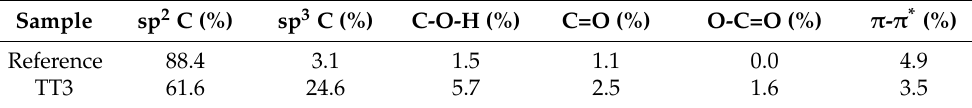
Table 8. Concentration of the different C chemical bonds (in%) got from XPS fitting of C 1s core level for the reference GF and the thermally treated TT3.